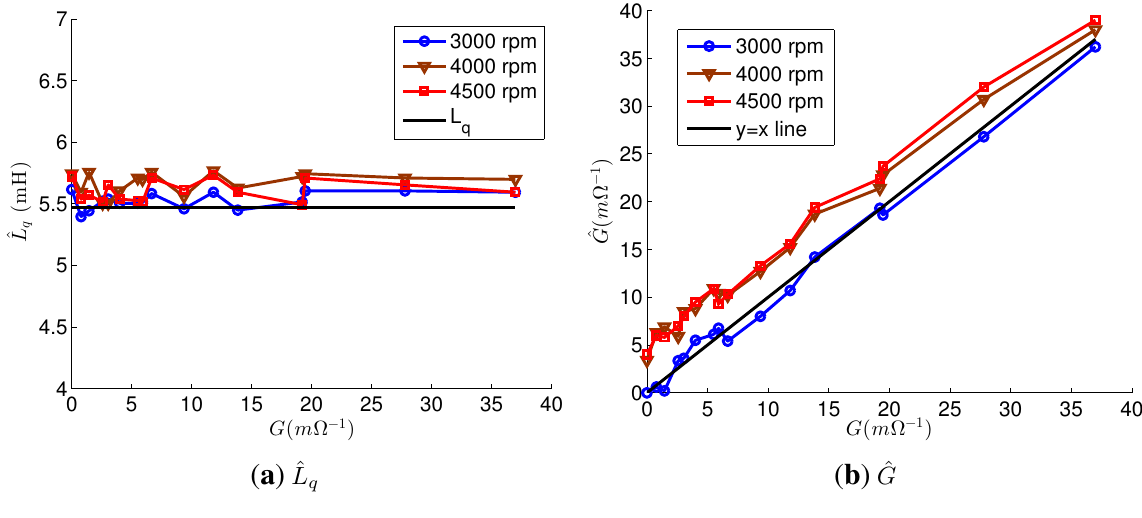
Figure 8. Estimation results of parameter estimation using accurate parameters. ( a ) ˆ L